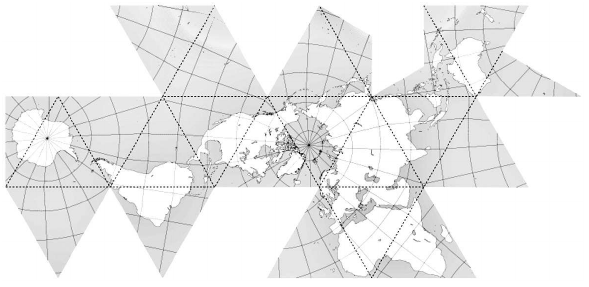
Figure 11. Dymaxion map of the world , Richard Buckminster Fuller, 1954, development of the Earth on the